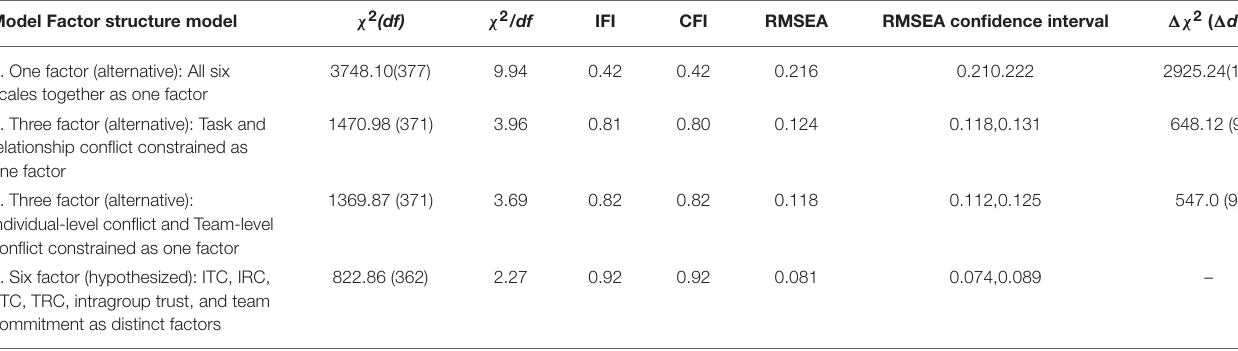
TABLE 2 | Confirmatory factor analysis of level-1